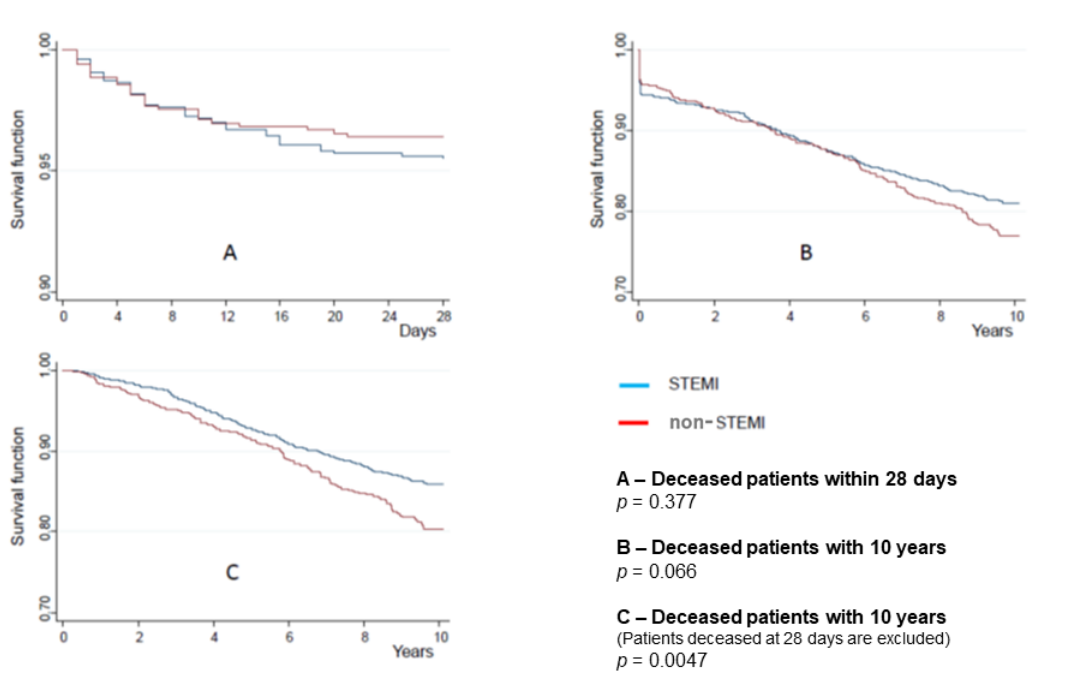
Figure 2. Cumulative survival according to the type of acute coronary